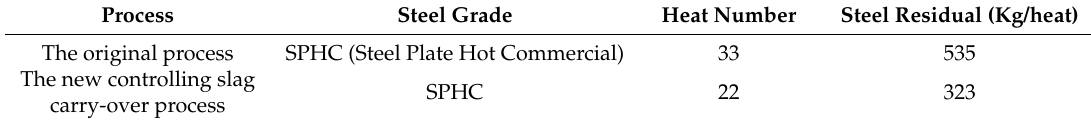
Table 2. Comparison of the steel residual during the ladle teeming process between the original and new controlling slag carry-over process.